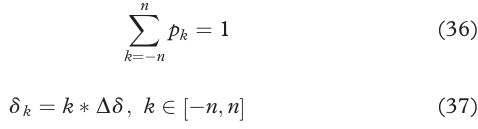
Figure 8 The experimental